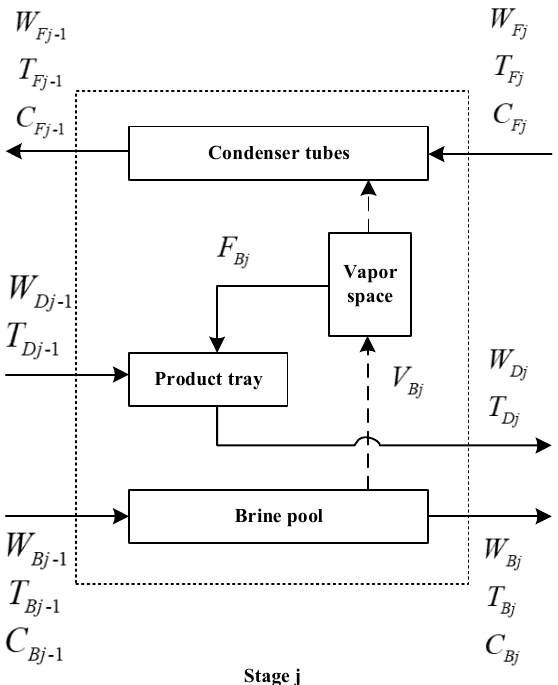
Figure 3. Structure chart of the j -th stage flash chamber. Flashing brine mass balance: